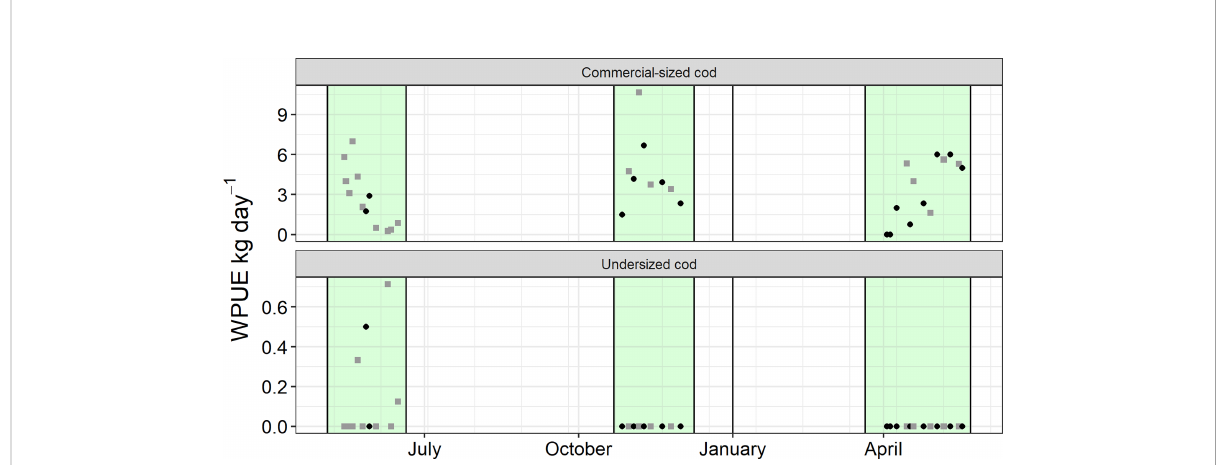
FIGURE 5 Mean WPUE (kg day -1 ) of commercial sized and undersized cod (Gadus morhua) when tested for leader net length. Black circles represent 100 m leader net, while grey squares represent 200 m leader net. Green background indicates the time period when both traps were simultaneously used. The black, vertical dashed line represent the division between 2017 and